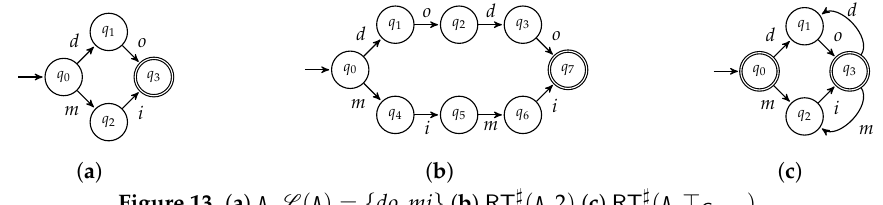
Figure 13. ( a ) A , L ( A ) = { do , mi } ( b ) RT (cid:93) ( A ,2 ) ( c ) RT (cid:93) ( A , (cid:62) Const )